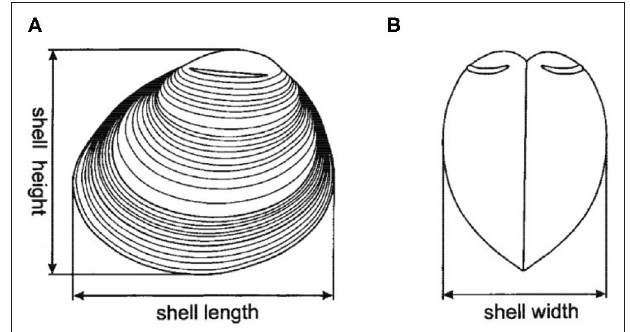
FIGURE 1 | Shell dimensions measured for all F1 clams from both Chioggia and Marennes clam groups, adapted from Grigorovich et al. (54). (A) Lateral view; (B) Frontal